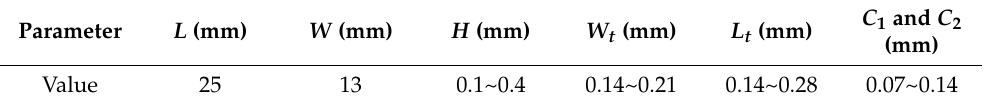
Table 5. Dimensions of microgripper.